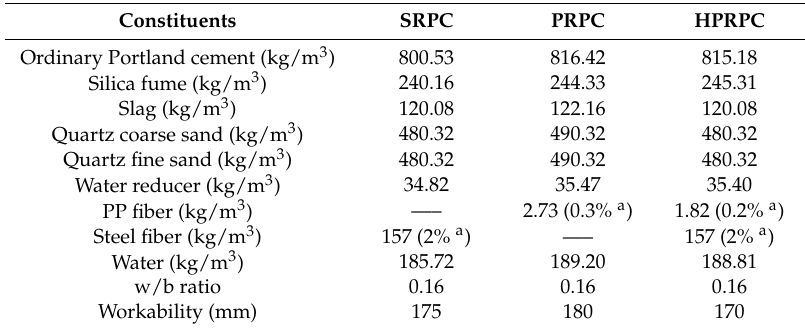
Table 2. Mix proportions for steel fiber reinforced RPC (SRPC), polypropylene fiber reinforced RPC (PRPC), and hybrid fiber reinforced